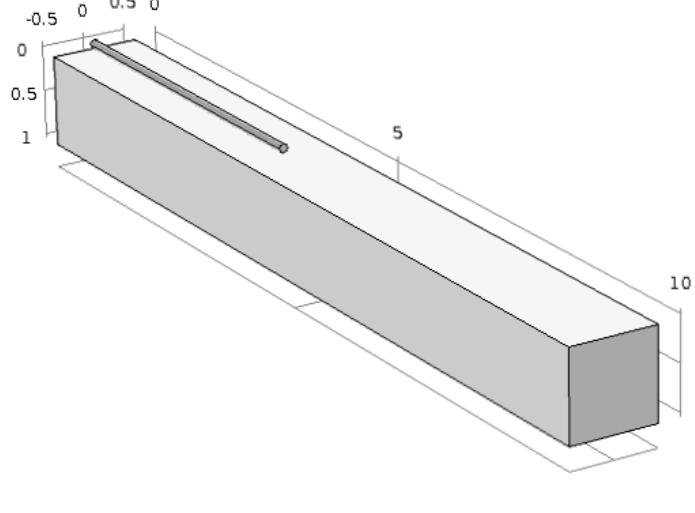
Figure 3. Geometric model of the cantilever beam and carbon fiber sensor.